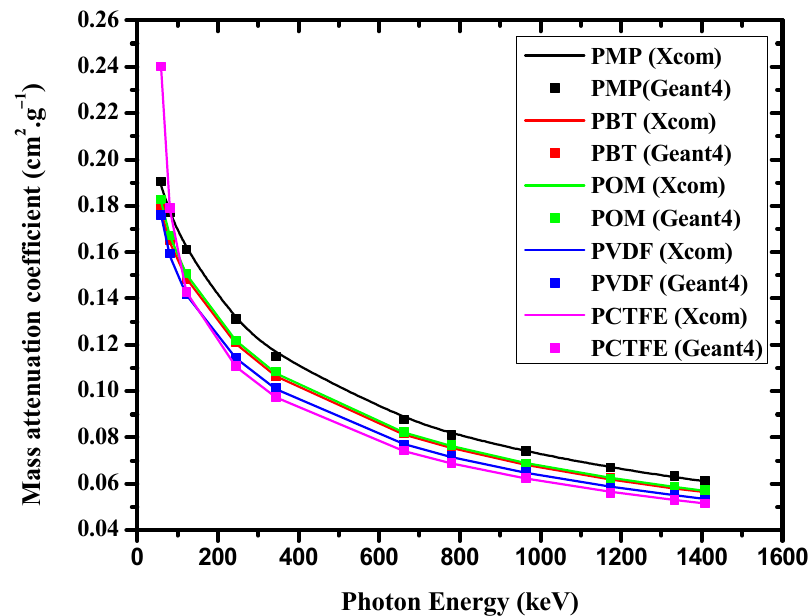
Figure 3. Mass attenuation coefficients of PMP, PBT, POM, PVDF, and PCTFE polymers as a function of photon energy from XCOM and Geant4.